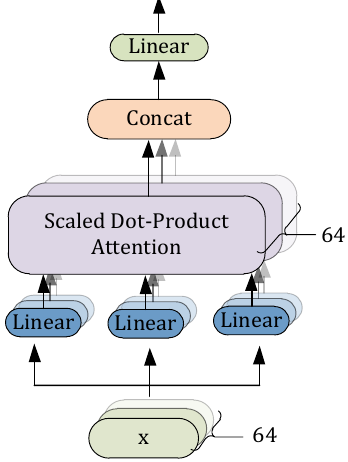
Figure 8. Features fusion module. Deep representation features and manual designed features are fused with multi-head attention. This study duplicates the input signal x and, respectively, puts them into three branches to construct key, query, and value. For each channel of x , linear transforms are used to compute each attention head. Finally, the independent attention outputs are simply con- catenated and linearly transformed to the expected dimension.